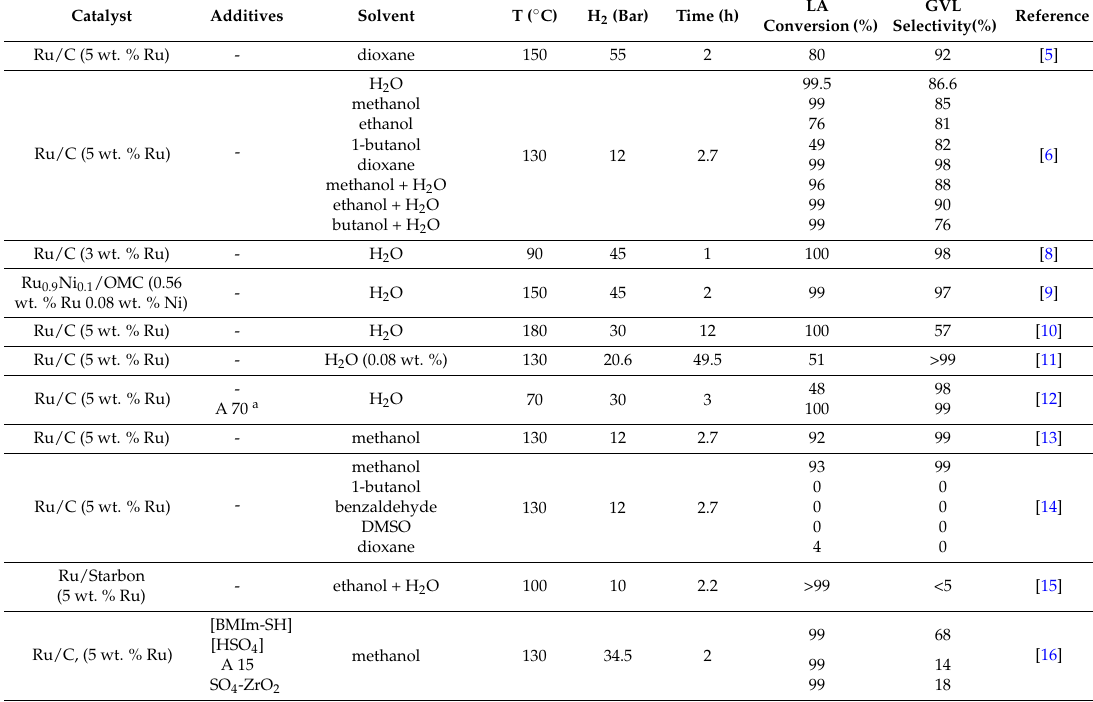
Literature overview on LA (levulinic acid) hydrogenation in batch set-ups using carbon-supported ruthenium